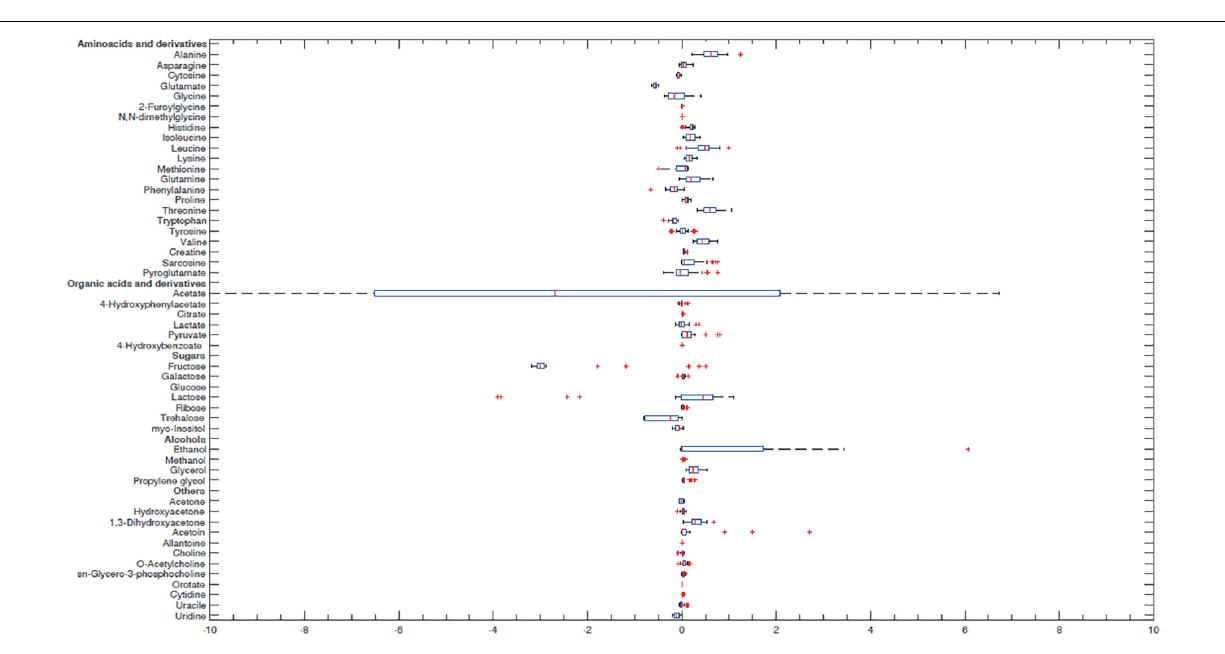
Frontiers in Microbiology |